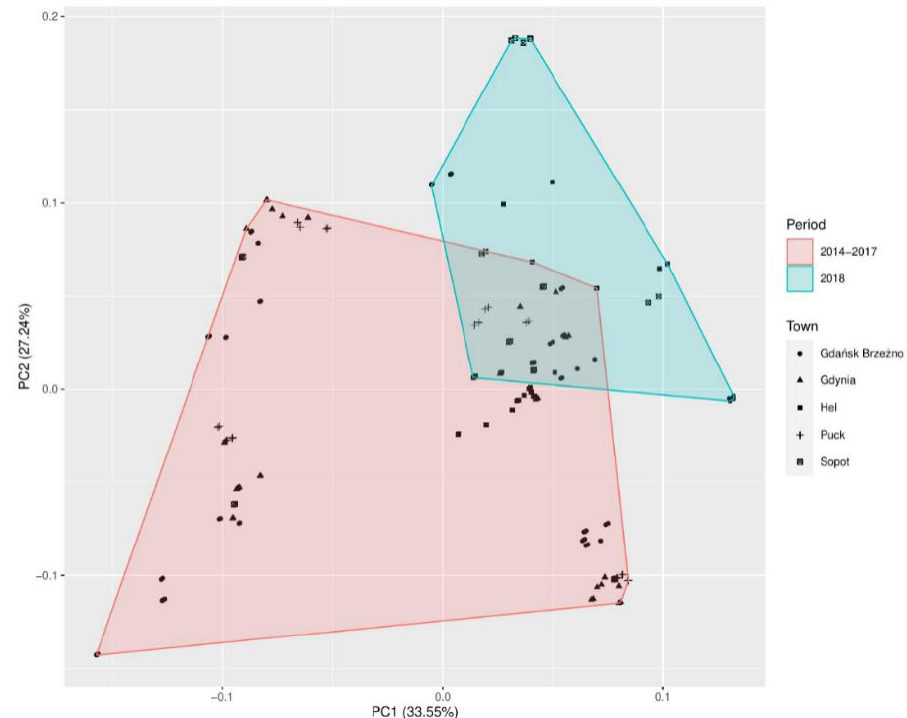
Figure 2. Principal component analysis (PCA) of mold and yeast-like fungi detected in air samples in the seaside towns and meteorological factors. The plot score of the first two principal components contains almost 60.78% of the explained variance. Two clusters can be distinguished: The red one is composed in the study period of 2014–2017 and the blue cluster in 2018. Table 2. The values of the correlation between PC1, PC2, and the variables used to build the